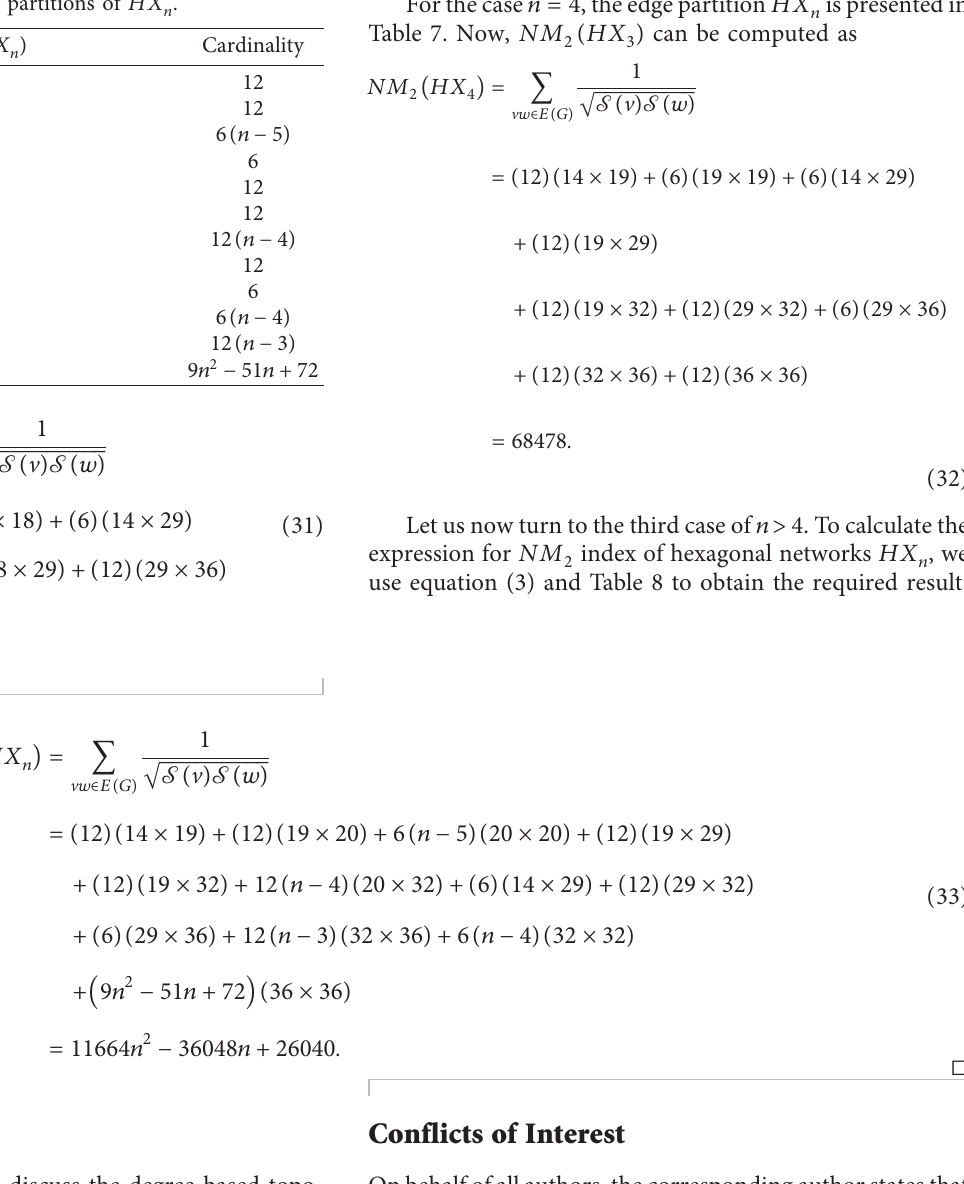
Table 8: Edge partitions of HX